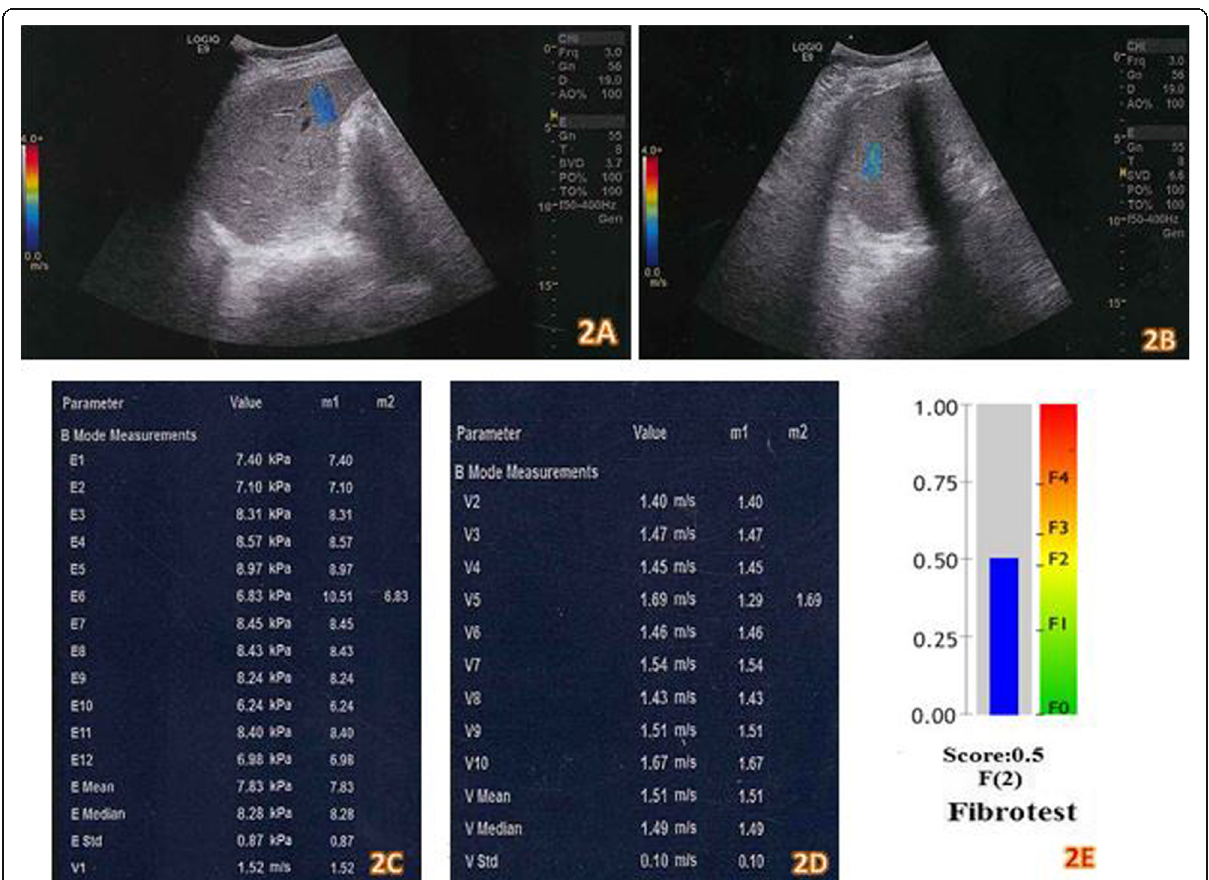
Fig. 2 F0-F1 stage: A female patient aged 38 years old with HCV chronic hepatitis and elevated AST and ALT. Conventional US reveals the following ( a and b ): Liver >>wave form surface (score 2), mildly coarse echopattern (score 2), smooth hepatic veins (score 1) “ cumulated score 5. ” No ascites, normal spleen size, dilated portal vein caliber (14 mm). 2D shear wave elastography ( c and d ): Velocity median value = 1.49 m/s. Stiffness median value =8.28 kPa. Fibrotest result was 0.5 denoting F2 stage ( e